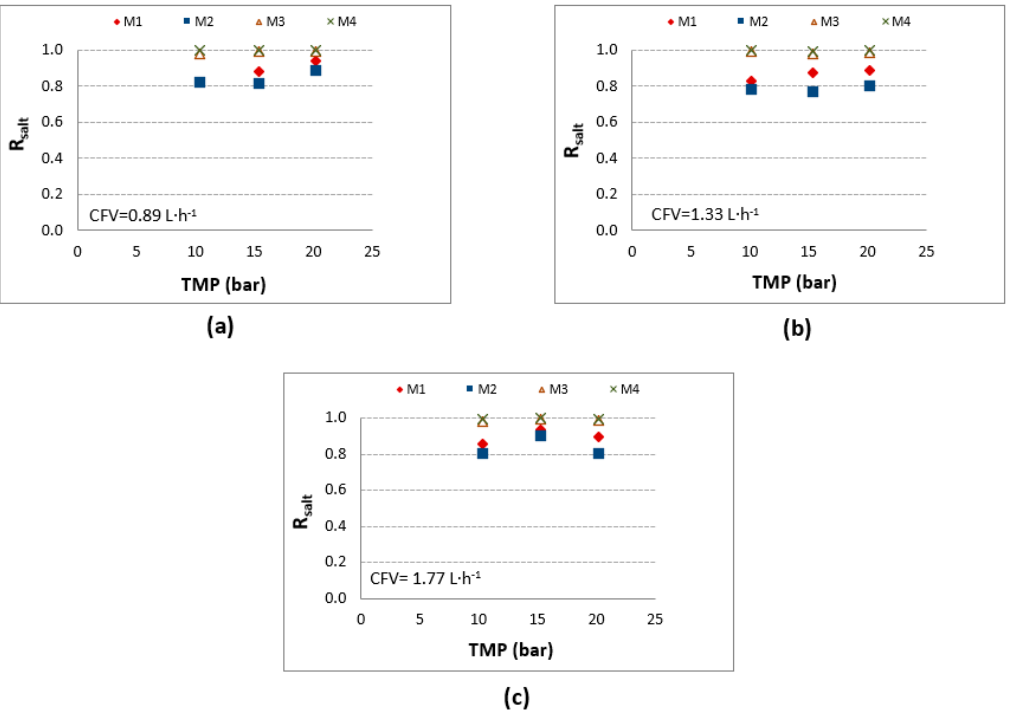
Figure 4. Influence of TMP on salt retention at different CFVs: ( a ) 0.89 L · h − 1 ; ( b ) 1.33 L · h − 1 ; ( c ) 1.77